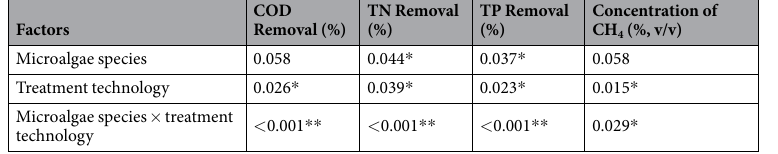
Table 3. P-values of factors and combined effects of factors for each parameter under different treatment technology based on analysis of variance. Note: Microalgae species: C. vulgaris FACHB-31, S. obliquus